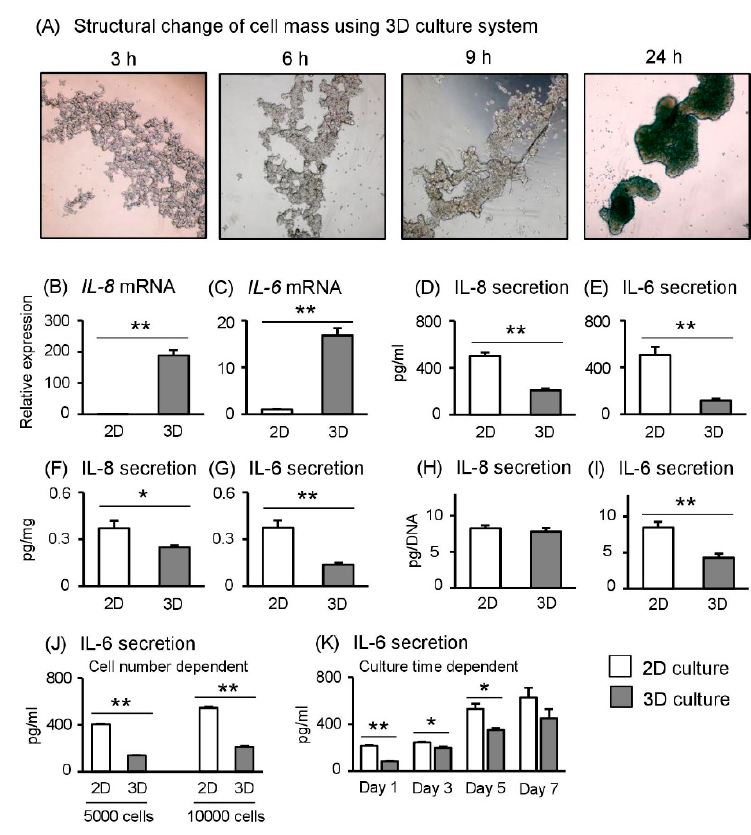
Figure 1. Effects of 3D culture conditions on inflammatory cytokines in Sw.71 cells. Sw.71 trophoblast cells were incubated in 2D or 3D culture plates. ( A ) Observation of structural changes of Sw.71 cells maintained in 3D (×40 magnification). ( B , C ) After 24 h incubation, IL-8 and IL-6 mRNA levels were measured using RT-qPCR ( n = 4). ( D , E ) After 24 h incubation, IL-8 and IL-6 concentrations in supernatants (/mL) were determined using ELISA ( n = 4). ( F , G ) After 24 h incubation, IL-8 and IL-6 concentrations in supernatants (/protein mg) were calculated ( n = 4). ( H , I ) After 24 h incubation, IL-8 and IL-6 concentrations in supernatants (/DNA concentration) were calculated ( n = 4). ( J ) After 24 h incubation, cell number-dependent IL-6 concentrations in supernatants (/mL) were determined using ELISA ( n = 4). ( K ) Culture time-dependent IL-6 concentrations in supernatants (/mL) were determined using ELISA ( n = 4). Data are expressed as mean ± standard error of the mean (SEM). Significant differences were detected using a t -test; p < 0.05 (*) p < 0.01 (**).